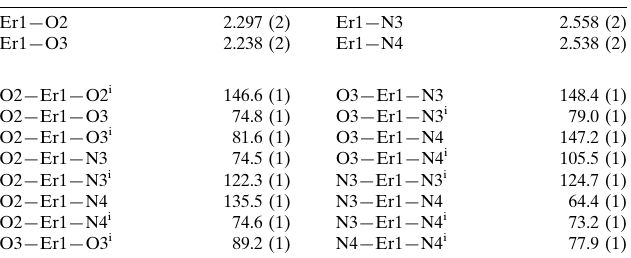
Selected geometric parameters (A˚ , (cid:2)